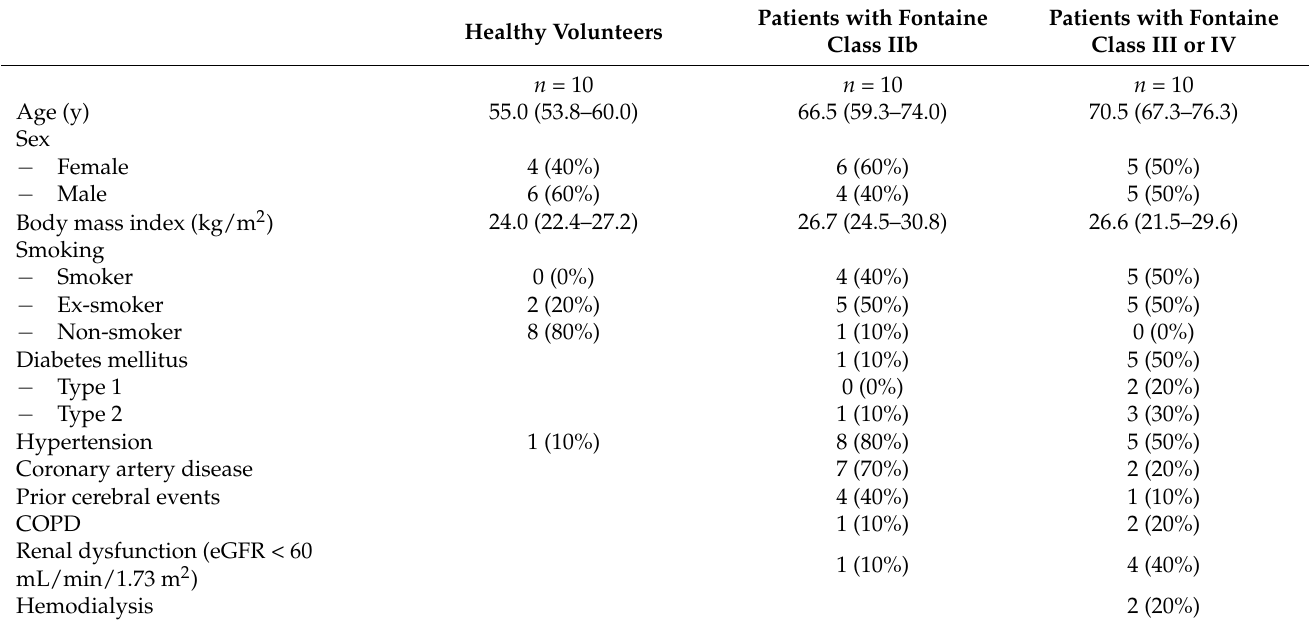
Table 1. Characteristics of included healthy volunteers, patients with Fontaine class IIb, and patients with Fontaine class III or